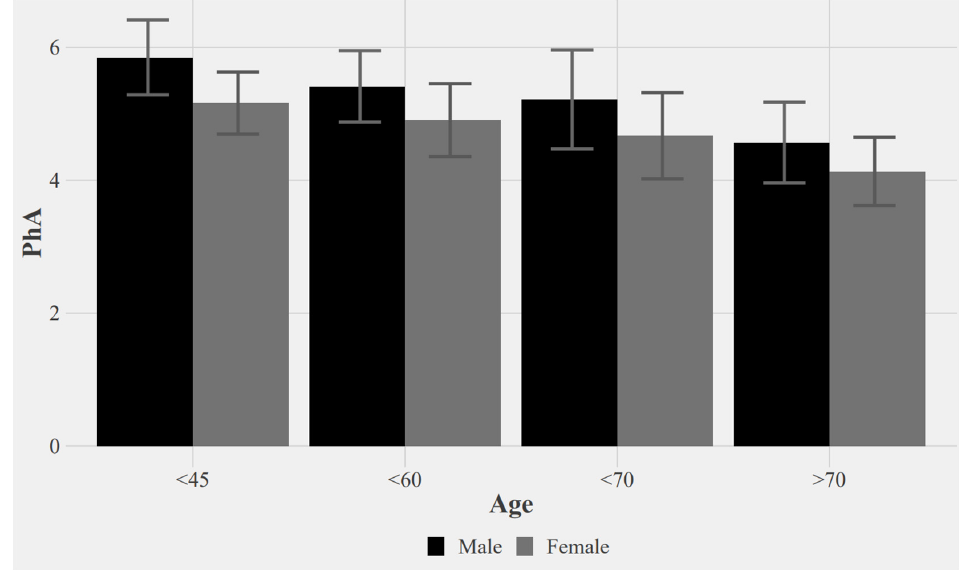
Figure 1. PhA values according to the age and sex of subjects.